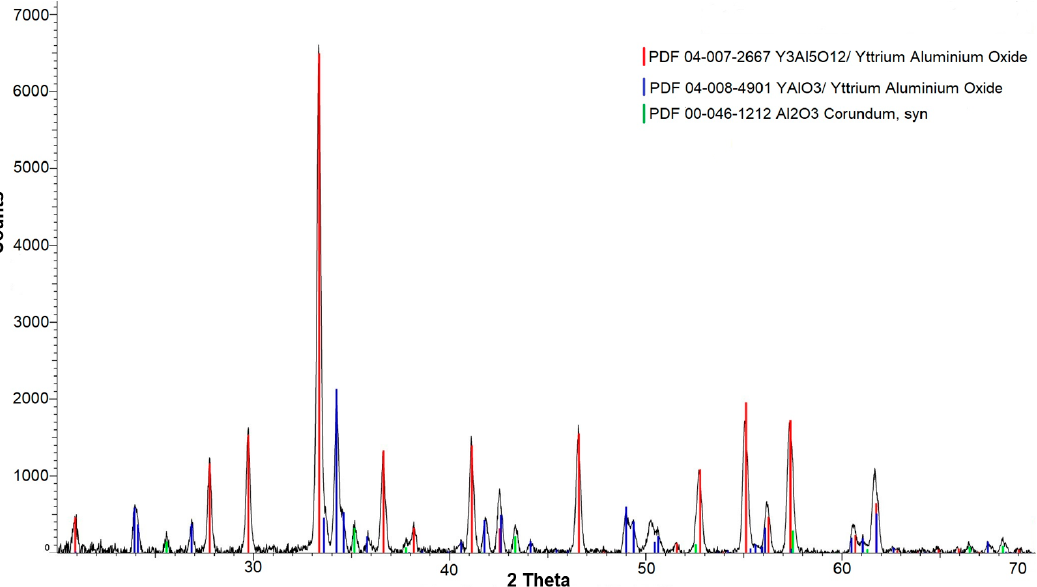
Figure 2. X-ray di ff raction spectra of YAG:Eu (6%). The red lines correspond to the phase of y tt rium– Figure 2. X-ray diffraction spectra of YAG:Eu (6%). The red lines correspond to the phase of yttrium– aluminum–garnet, the blue lines correspond to y tt rium–aluminum–perovskite YalO 3 , and the green aluminum–garnet, the blue lines correspond to yttrium–aluminum–perovskite YalO 3 , and the green Crystals 2023 , 13 , x FOR PEER REVIEW lines correspond to the phase of corundum. lines correspond to the phase of corundum.